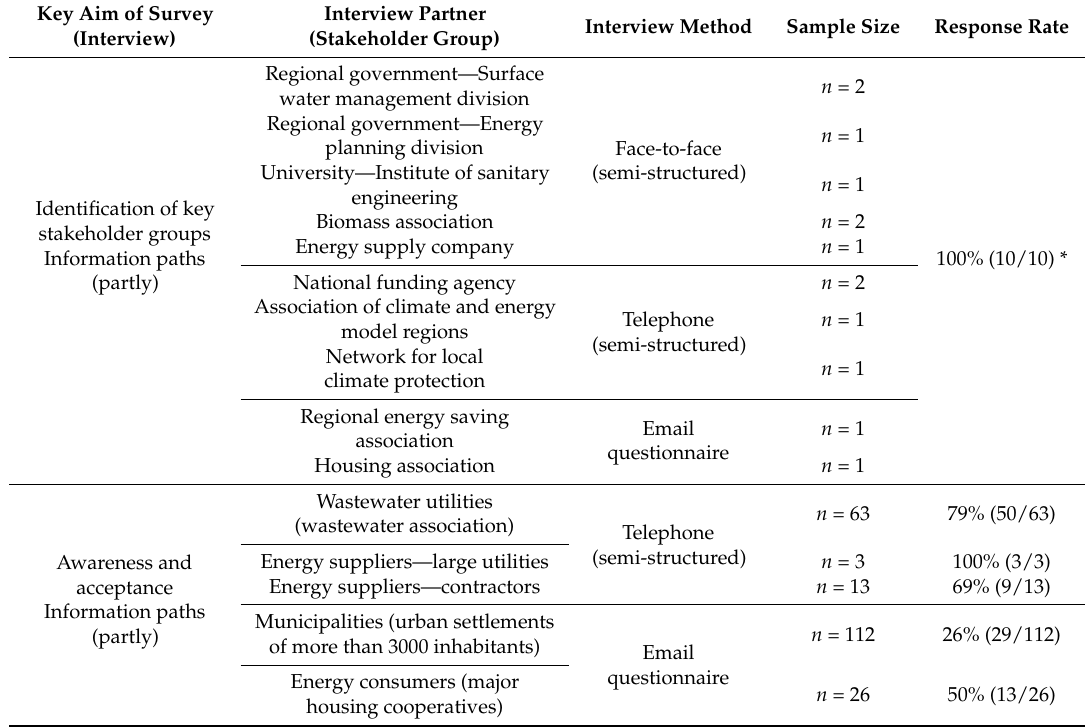
Table 1. Stakeholder analysis data—aim of survey, interview partners, applied methods, sample sizes, and response